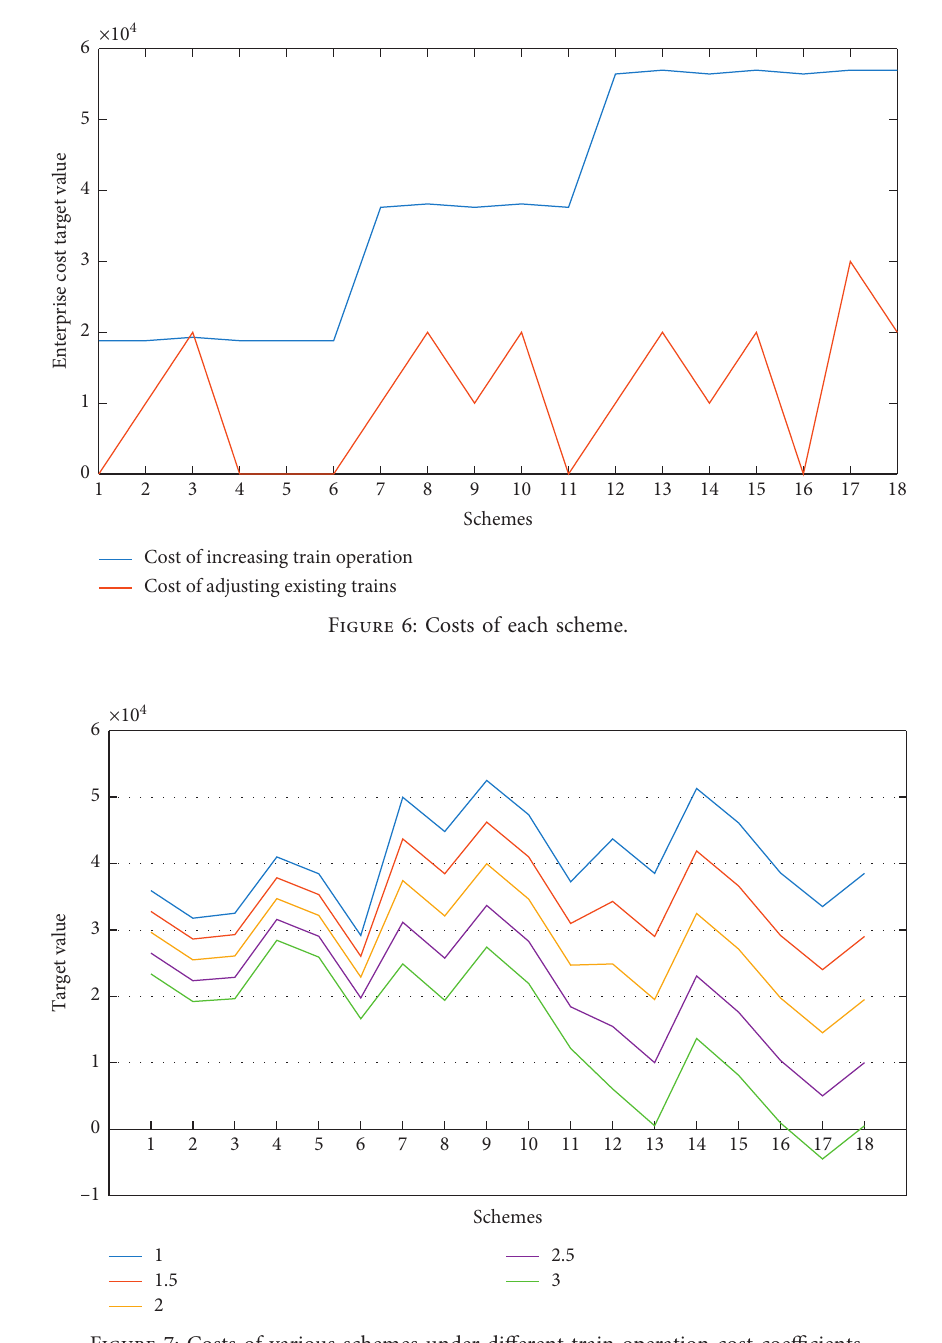
Figure 7: Costs of various schemes under different train operation cost coefficients.